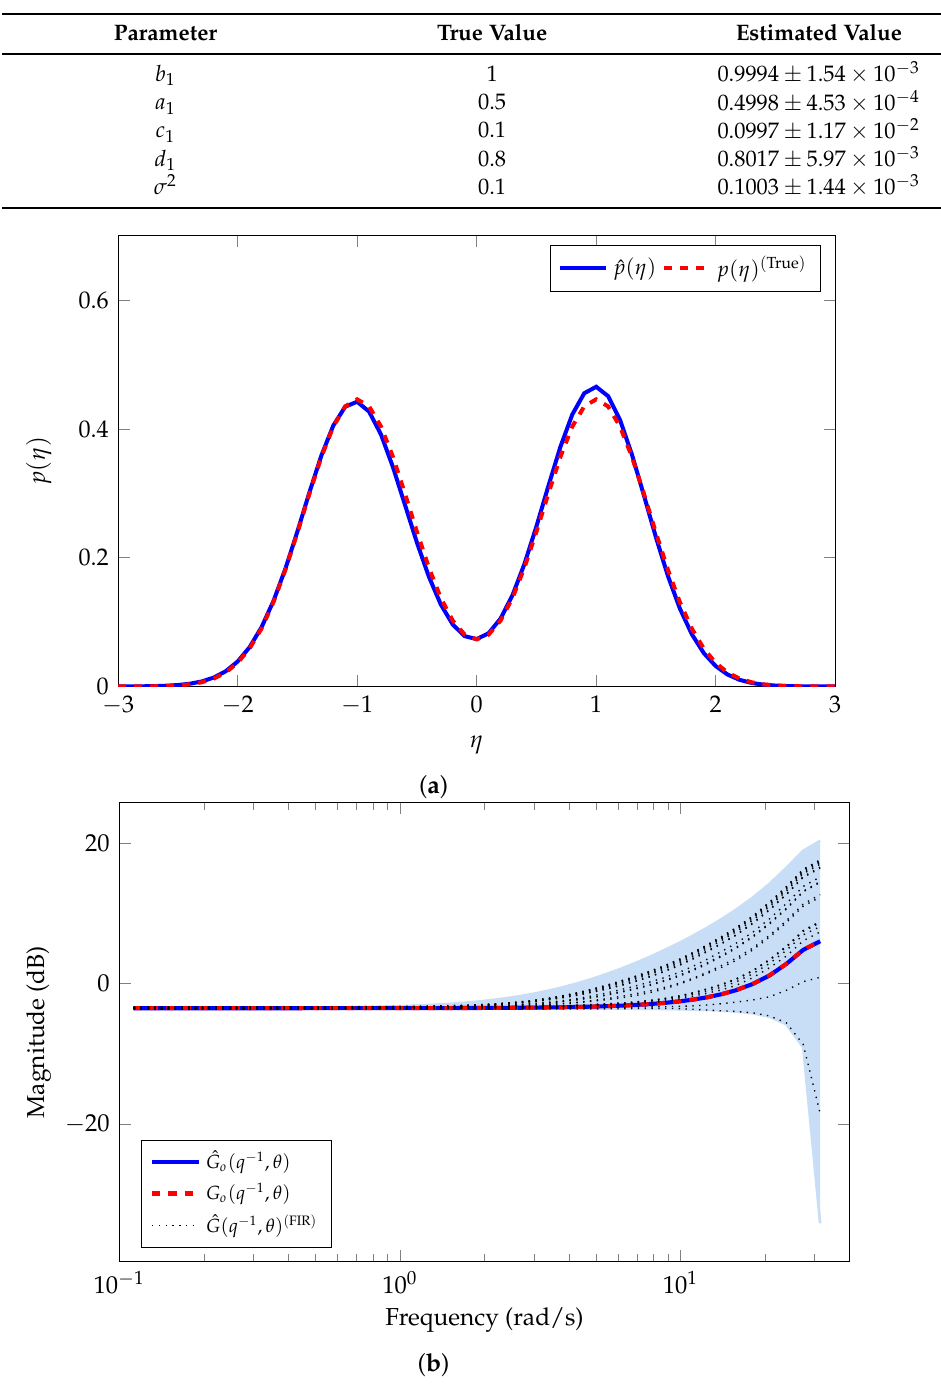
Figure 3. Nominal model and error-model distribution estimated for Example 1. ( a ) Estimated error-model distribution. ( b ) Estimated nominal model G o ( q − 1 , θ )